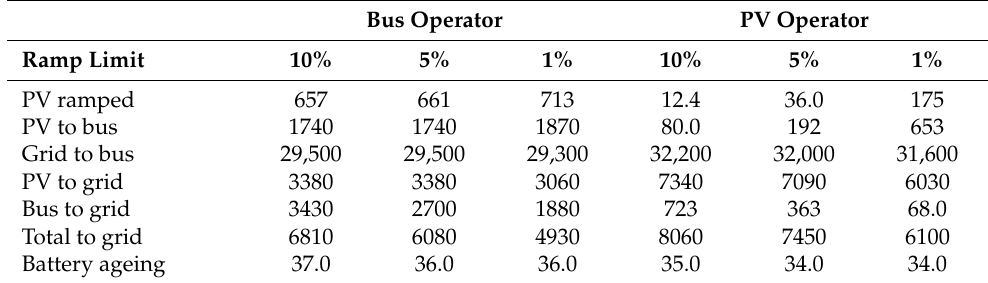
Table 2. Cost of PV ramped, PV energy fed into buses, grid energy fed into buses, PV energy fed into the grid, energy from BEB batteries fed into the grid, total energy fed into the grid, and battery ageing (all in SGD) for both objectives and three different ramp rate limits for one week.